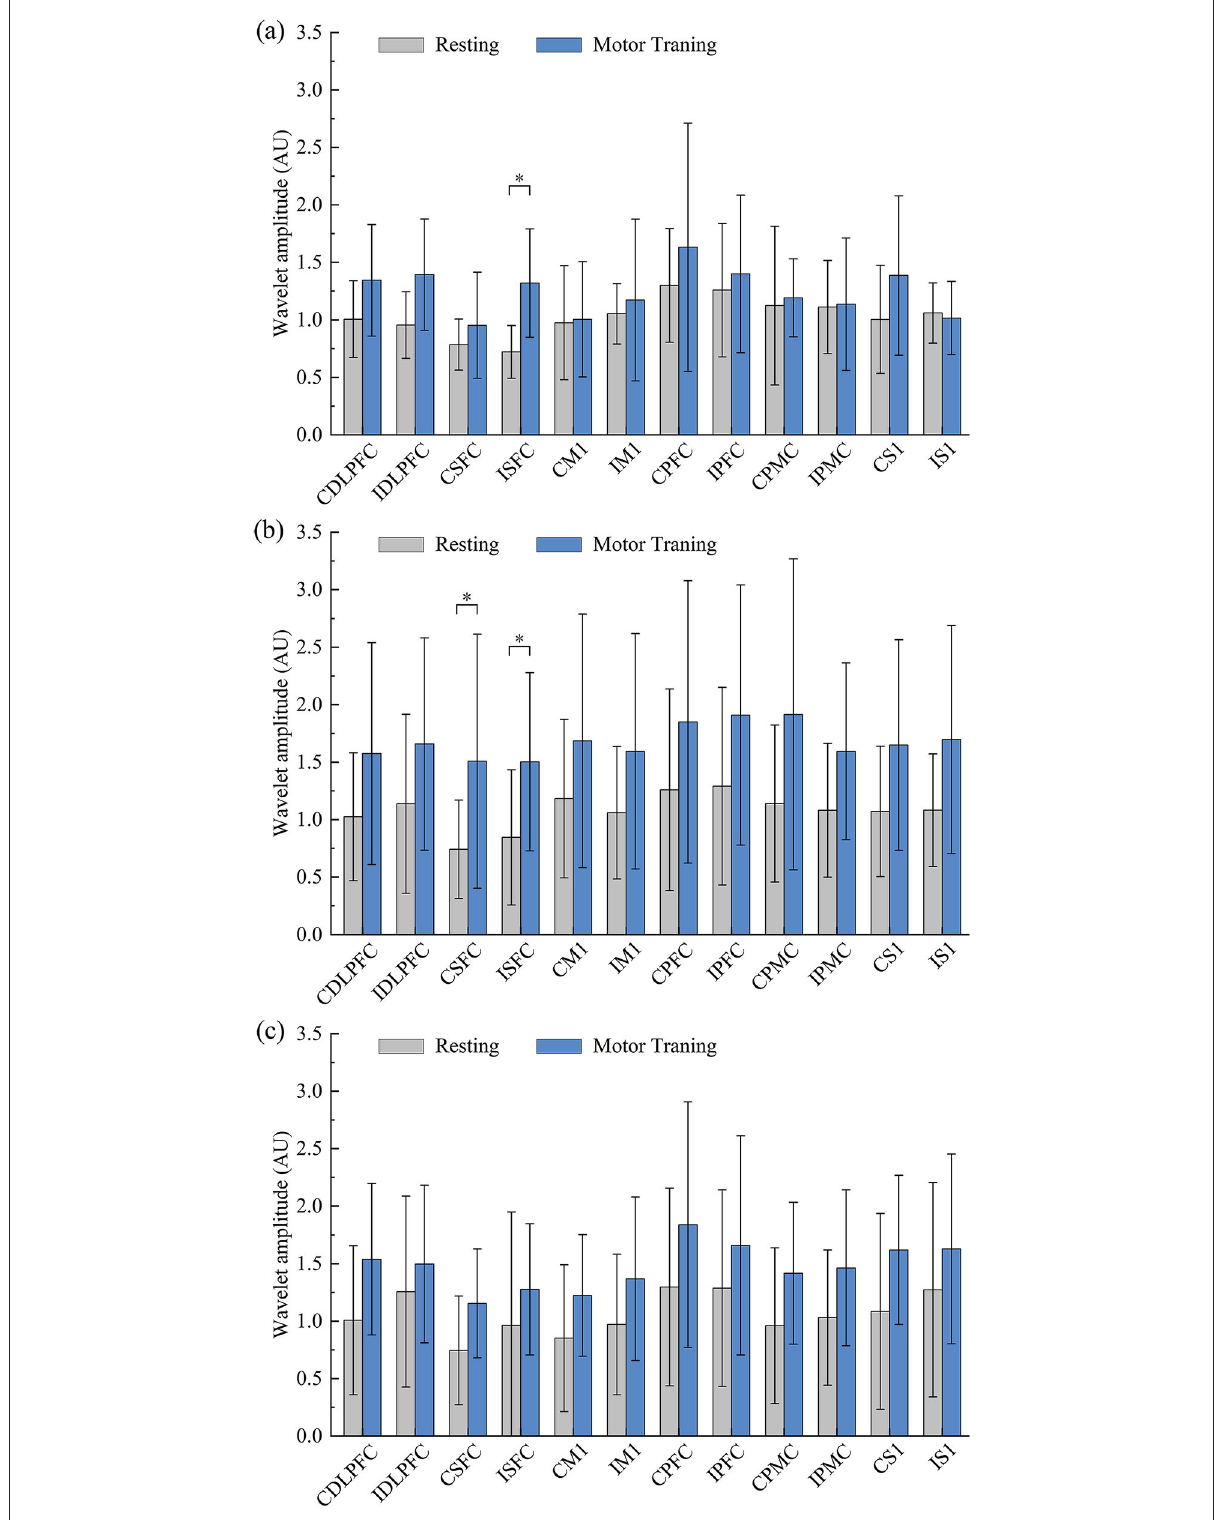
FIGURE3 Comparative results for WA values between resting and training states in mild (a) , moderate (b) , and severe (c) groups (* p <